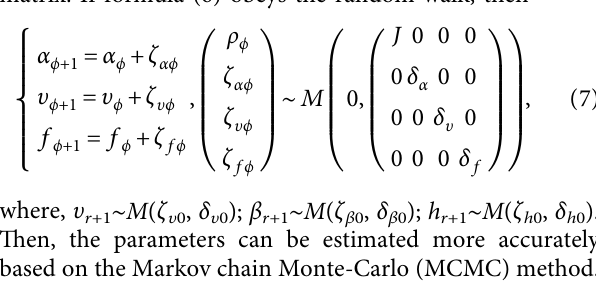
Figure 1: Schematic diagram of continuous